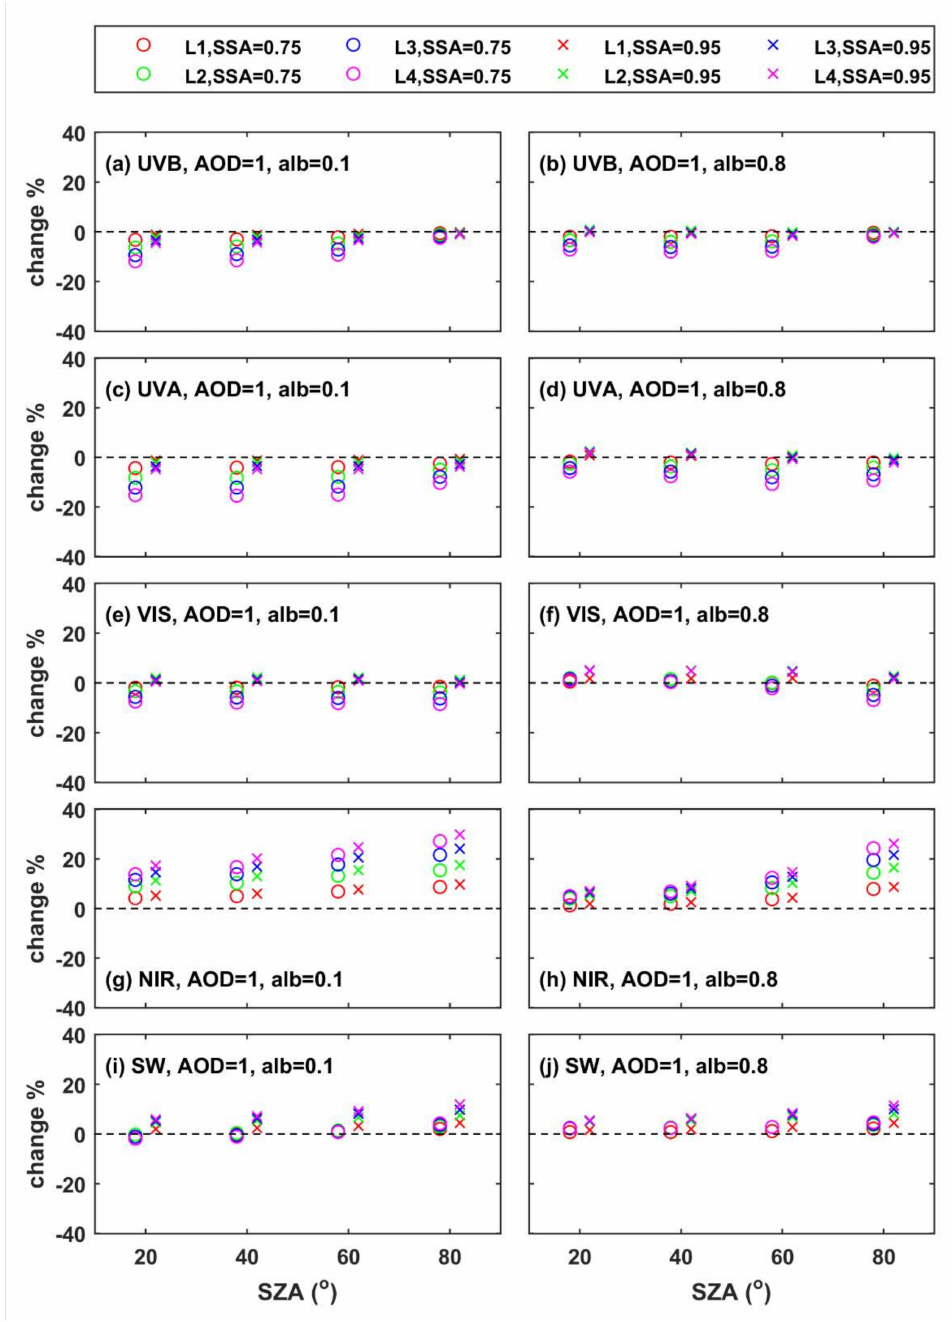
Figure 7. Change (in %) in the UDI at the TOA (realistic—default) for different altitudes of the aerosol layer, SSA and surface albedo. The presented results are for AOD = 1 and TCWV = 1 g/cm 2 . Different rows represent different spectral regions (UVB, UVA, VIS, IR). Different columns represent different surface albedo (left: 0.1, right: